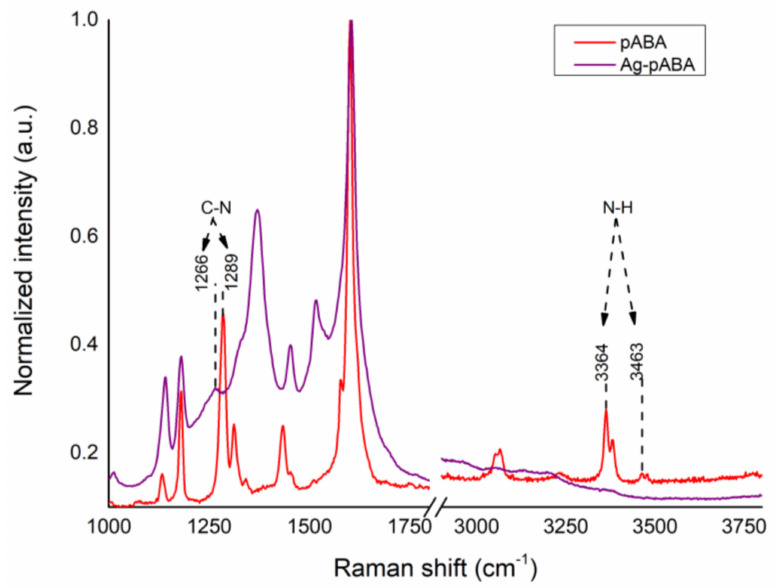
Figure 4. Raman analysis using 405 nm excitation laser. Non-resonant Raman spectrum of pABA (red trace), and Surface-Enhanced Resonant Raman Spectroscopy (SERS) spectrum of Ag-pABA (purple